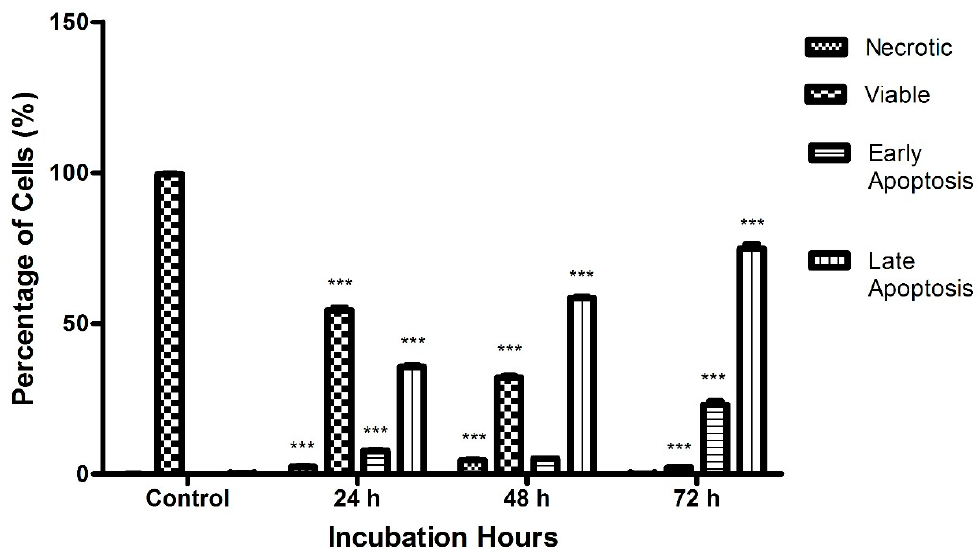
Figure 7. The effect of exposure time on the raphasatin-induced rate of apoptosis in the MCF-7 cells. The cells were treated with 9.84 µ M (IC 50 ) concentration of raphasatin for 24–72 h. The data comparing the percentage of cells between the untreated with treated, in terms of viable, early, and late apoptosis and necrotic for 24, 48, and 72 h of incubation. The data expressed as mean ± SD. *** p < 0.001.